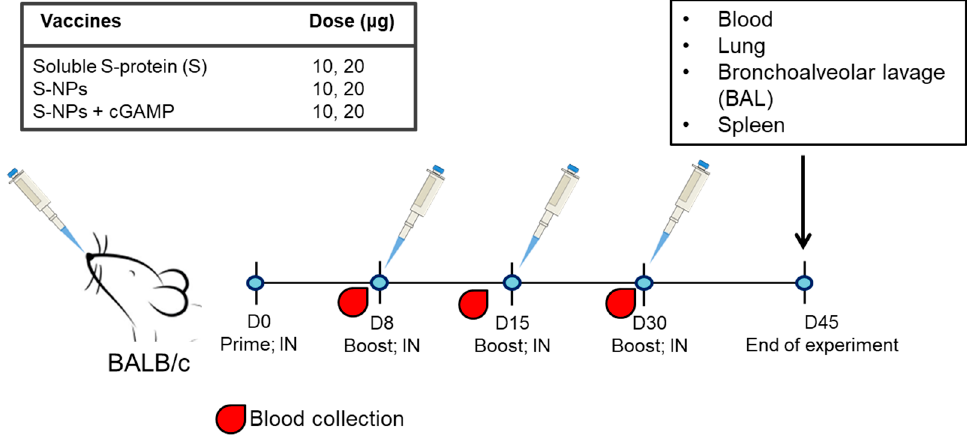
Figure 1. Schematic diagram of immunization and sample collection. Mice were administered intranasally with soluble S-protein, S-NPs, or S-NPs + cGAMP at 10 or 20 μ g/dose. Prime immunization was performed on day 0, followed by three booster shots on days 8, 15, and 30. Sera were collected from immunized mice on days 7, 14, and 29. On day 45 post-immunization, mice were euthanized and samples including blood, lung, BAL, and spleen were harvested for assessment of humoral and cell-mediated immune responses.